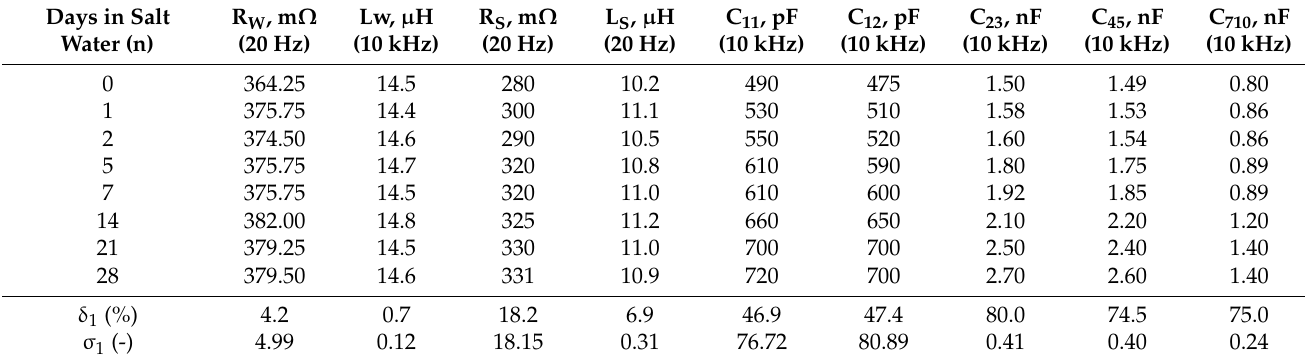
Table 2. Measurement results of CT1 (n = 0 stands for the nominal parameters of the cable).